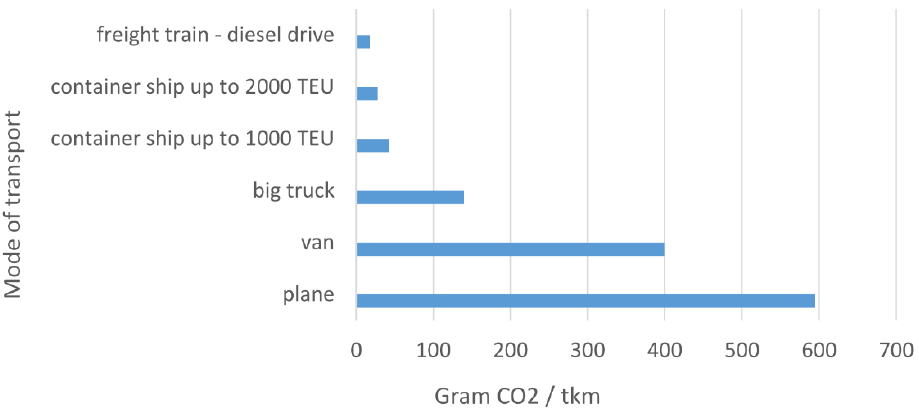
Figure 3. Comparison of CO 2 emission from the transport of one ton of goods per km [42].